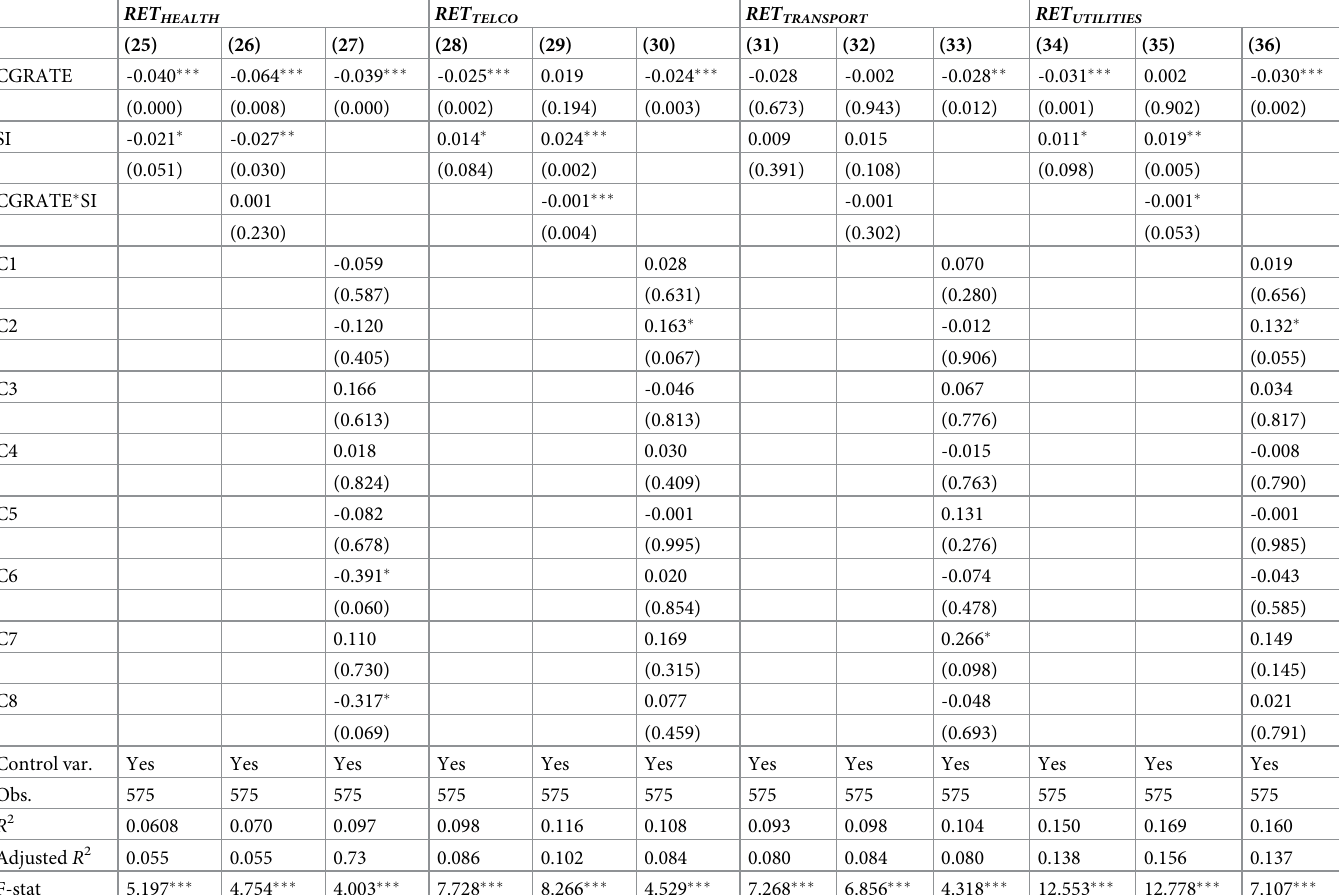
Table 6. Robustness tests: Alternative dependent variables using different sector indices